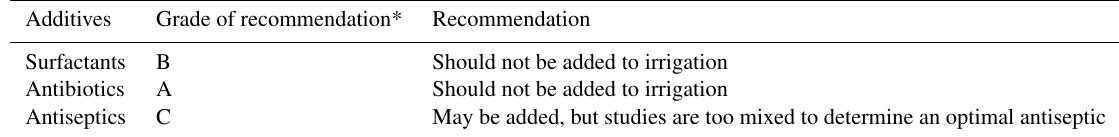
Table content reproduced with permission from Kavolus et al.